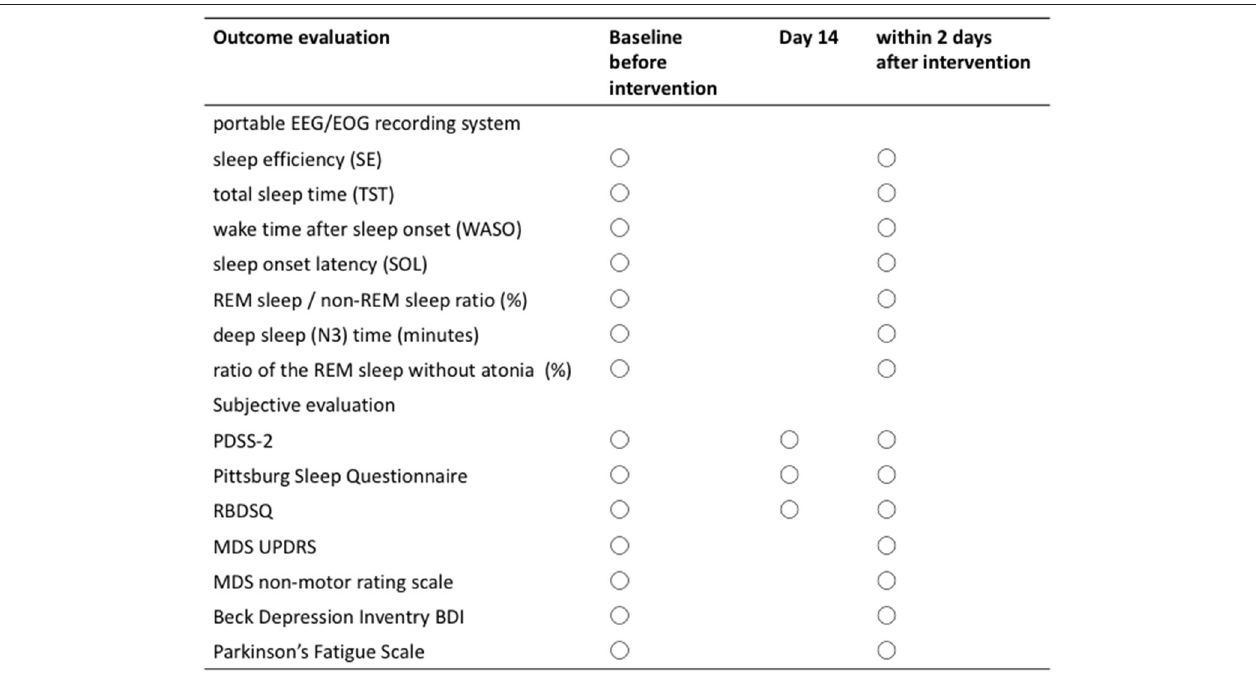
FIGURE 2 | Schedule of examinations and